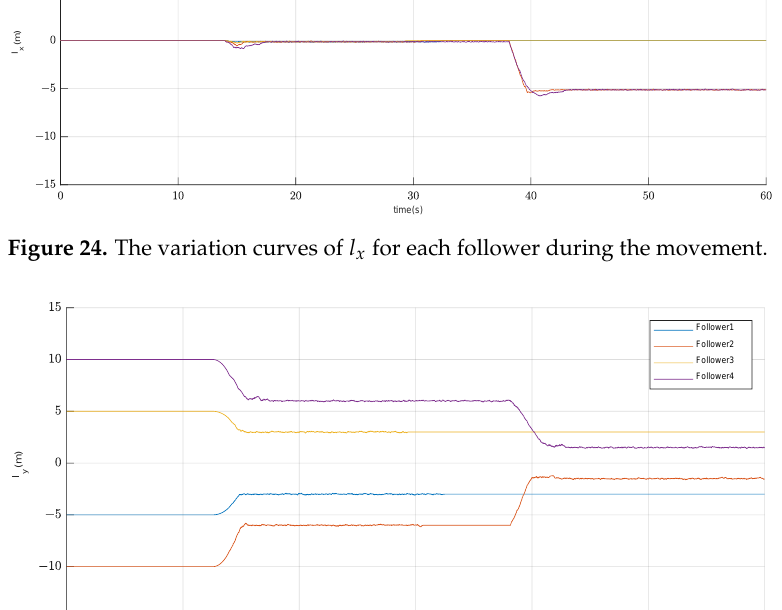
Figure 25. The variation curves of l y for each follower during the movement.